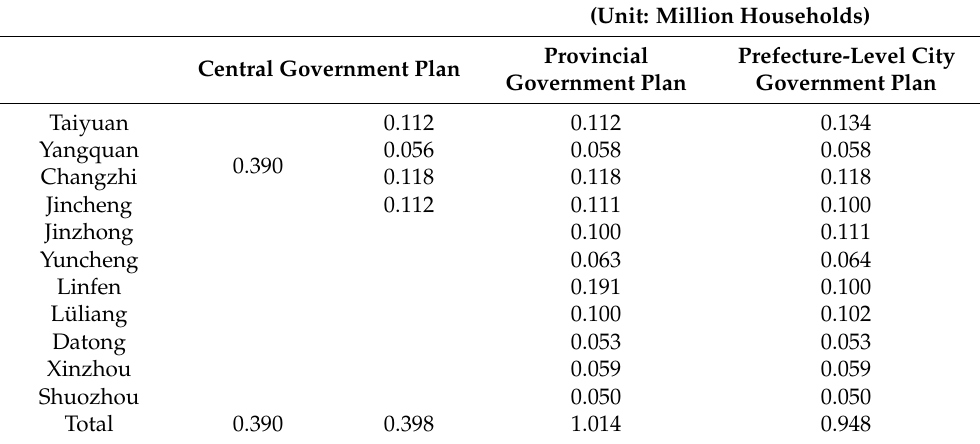
Table 4. Shanxi province’s clean heating transition targets at the three levels of